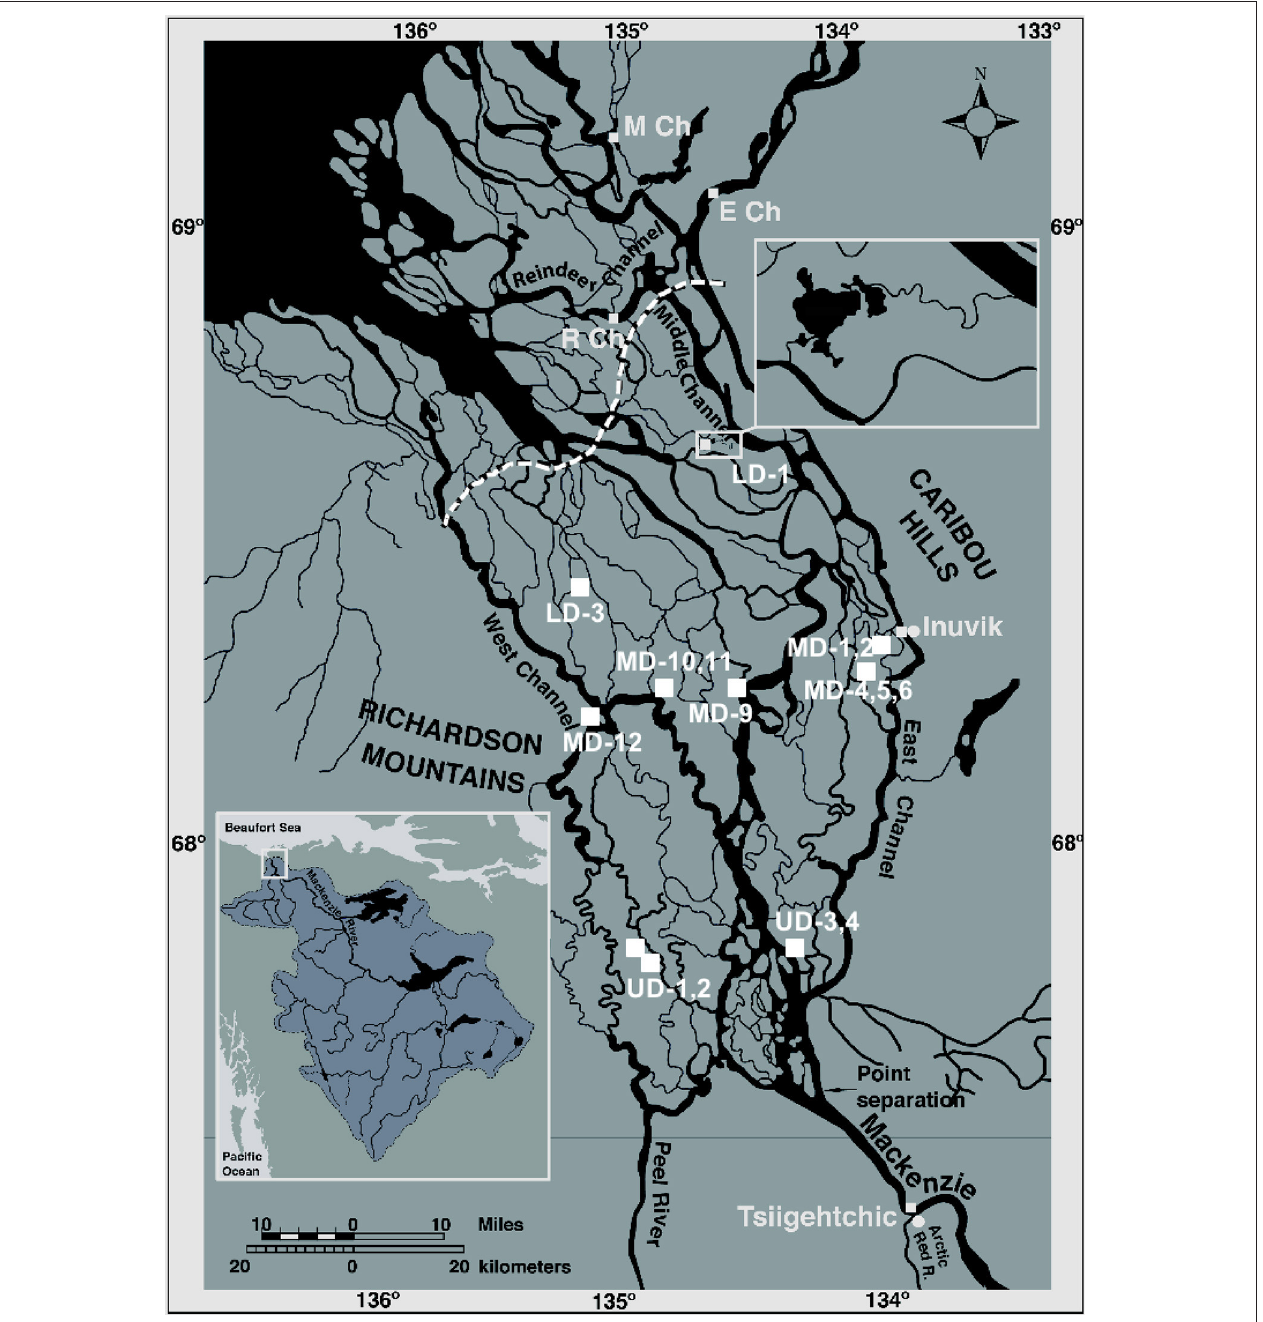
FIGURE 1 | Map of the Mackenzie River delta with the major tributaries, distributary channels and geographic features labeled. Sampling locations are indicated with white squares. The three outer delta sites (Reindeer Channel, R Ch; Middle Channel, M Ch; East Channel, E Ch) were analyzed by Goñi et al. (2000, 2005) and are included in this paper for comparison. The dashed white line indicates the treeline (MacKay, 1963). The inset in the upper right-hand corner shows an expansion of the region around the Lake LD-1 sampling site to show how this lake is connected to the river channels. The inset in the lower left-hand corner shows the Mackenzie River watershed, with a white box drawn around the